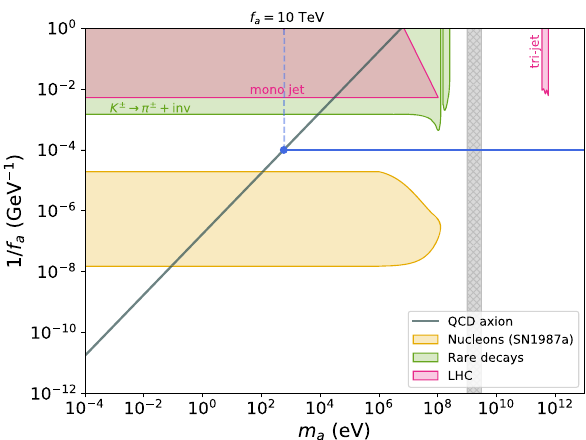
Fig. 3 Coupling to gluons. The excluded areas rely on considering exclusively the coupling g agg by itself. The SN1987a limit was com- puted in Ref. [15], while the rare decays and LHC exclusions are obtained using the results of Ref. [49] and Refs. [20,50], respectively. Particular models are represented by the overlaid lines, the black one corresponding to the QCD axion and the blue one to heavy axion mod- els (here for a benchmark choice of f a = 10TeV). See Sect. 4.4 for more details. We provide exclusion plots without superimposed